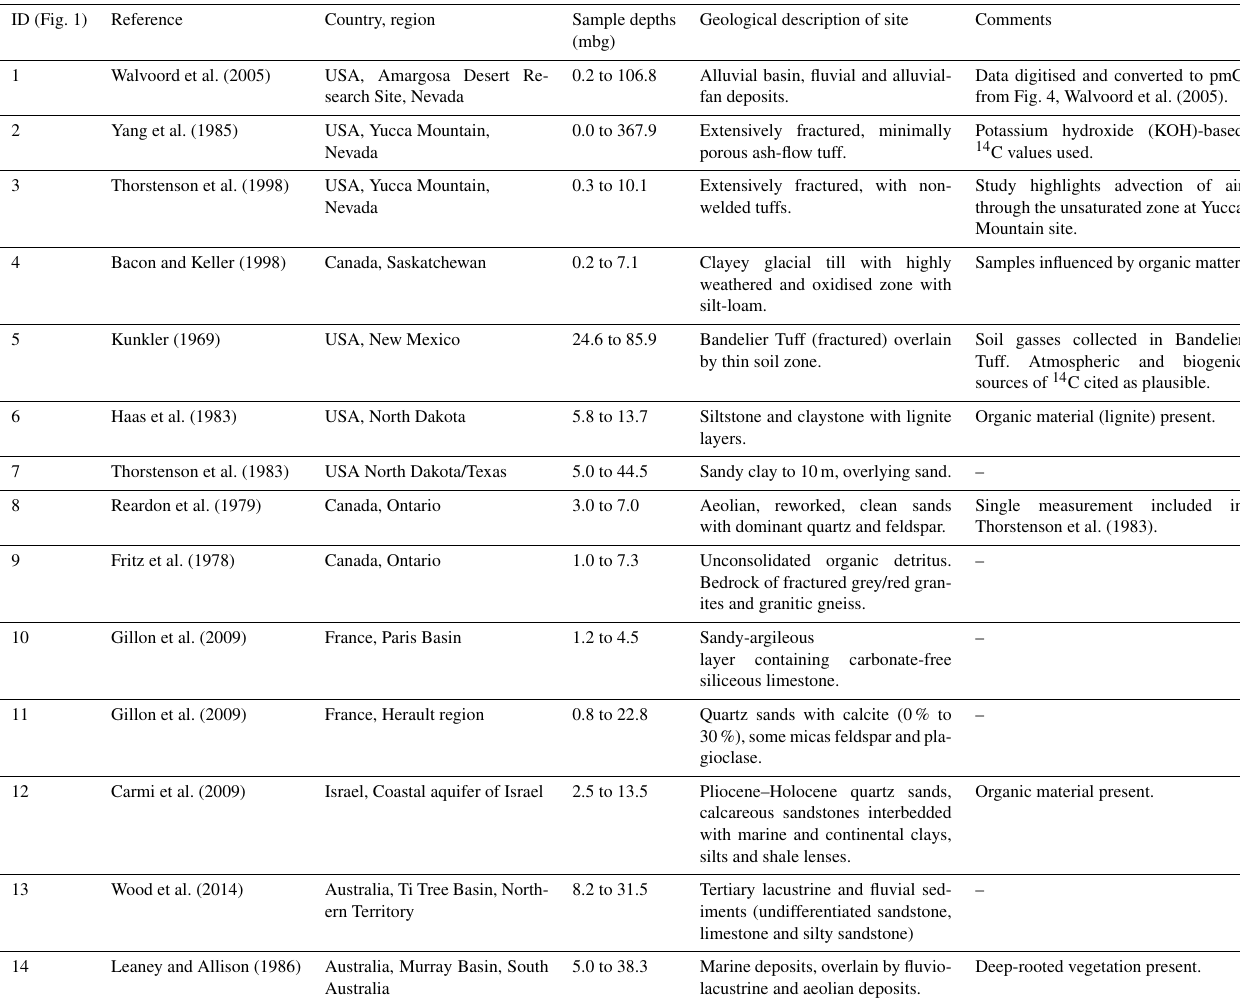
Table 1. Summary of studies of 14 C uz . Sample depths are presented in metres below ground